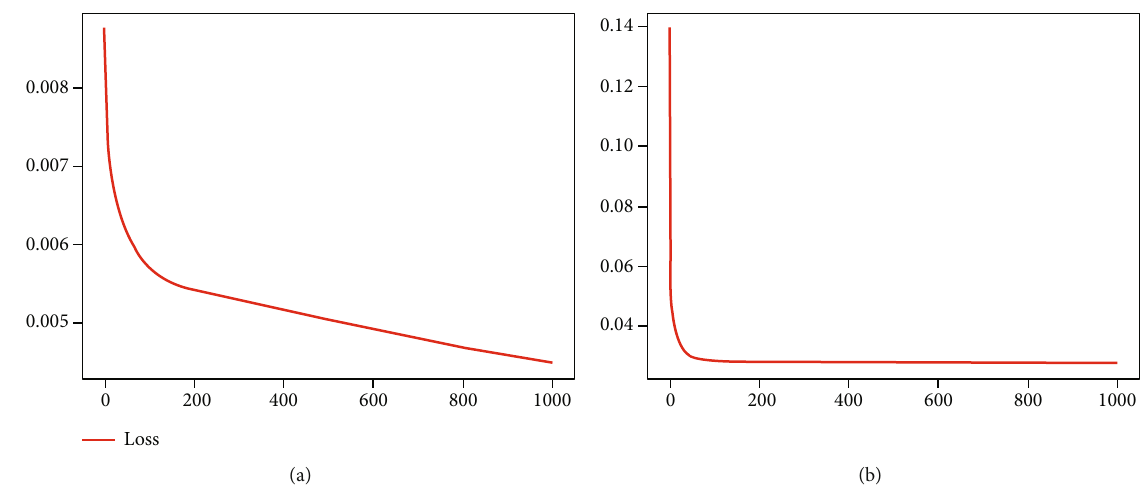
Figure 10: The speci fi c loss (MSE) at each epoch corresponding to the training process of the intelligent relative permeability model of the fl ooding phase and displaced phase, respectively. (a) The speci fi c loss (MSE) at each epoch corresponding to the training process of the intelligent relative permeability model of the fl ooding phase. (b) The speci fi c loss (MSE) at each epoch corresponding to the training process of the intelligent relative permeability model of the displaced phase.